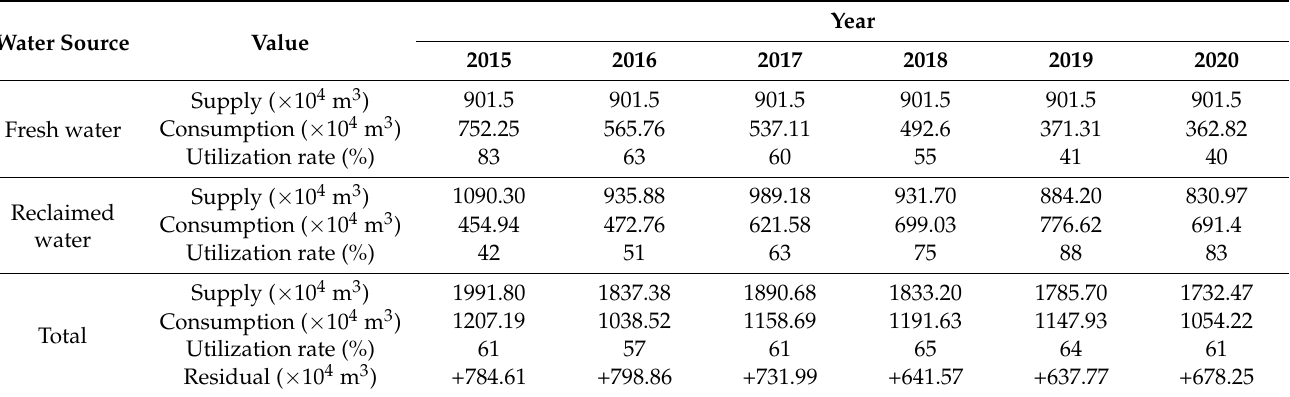
Table 4. Water supply and consumption in the study area from 2015 to 2020. Residual = supply– consumption.